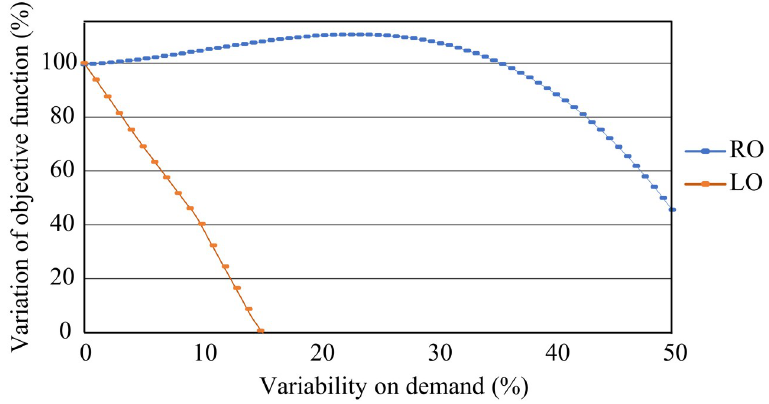
Fig 9. Objective function percentage value for different level of demand uncertainty for a given budget.